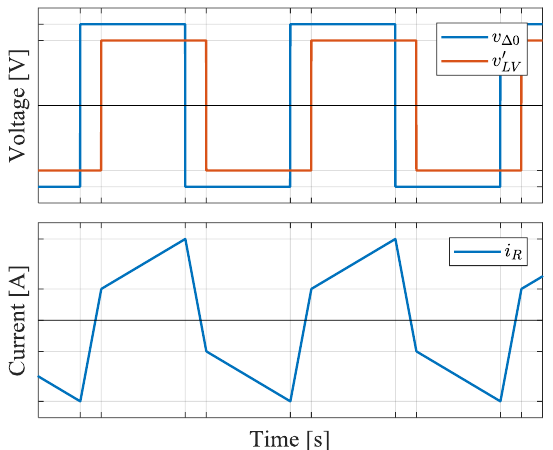
Fig. 3. Ideal PSC with SQM waveforms 169 Figure 3. Ideal Phase-Shift Control (PSC) with Square Wave Modulation (SQM)